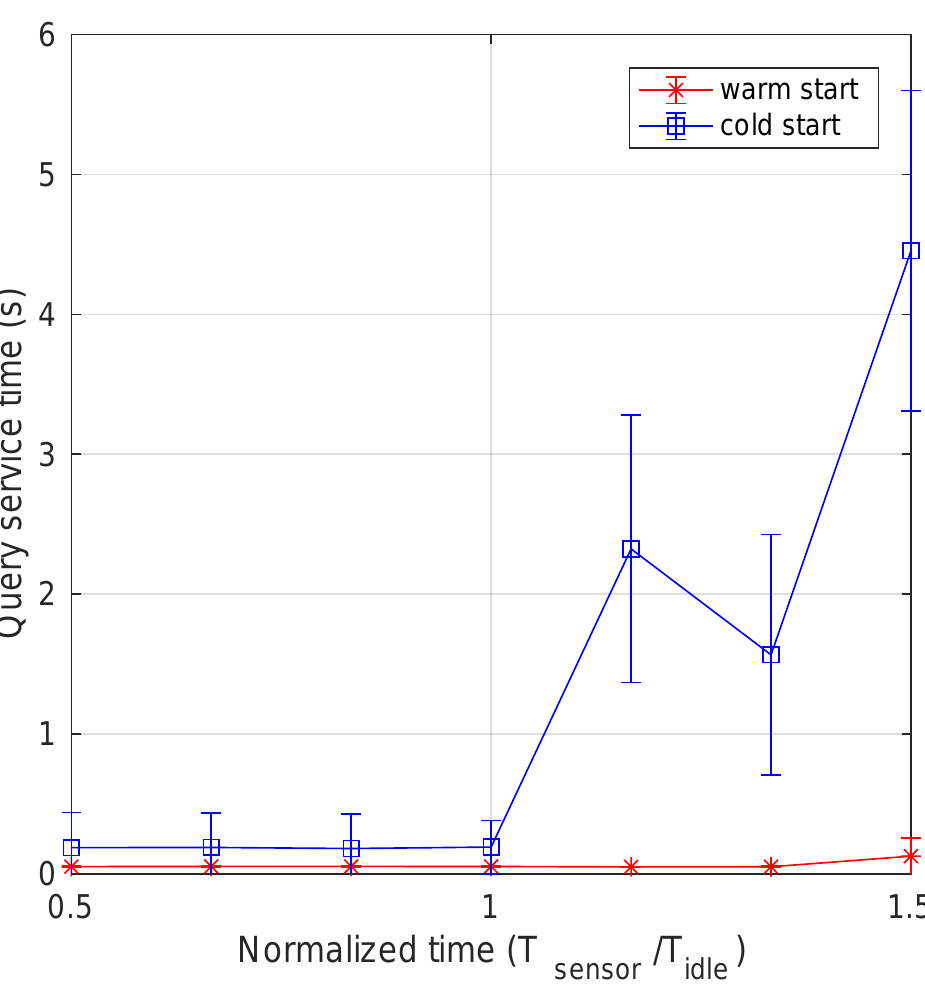
Figure 10. Query time as a function of the normalized transmission period for both cold and warm start.